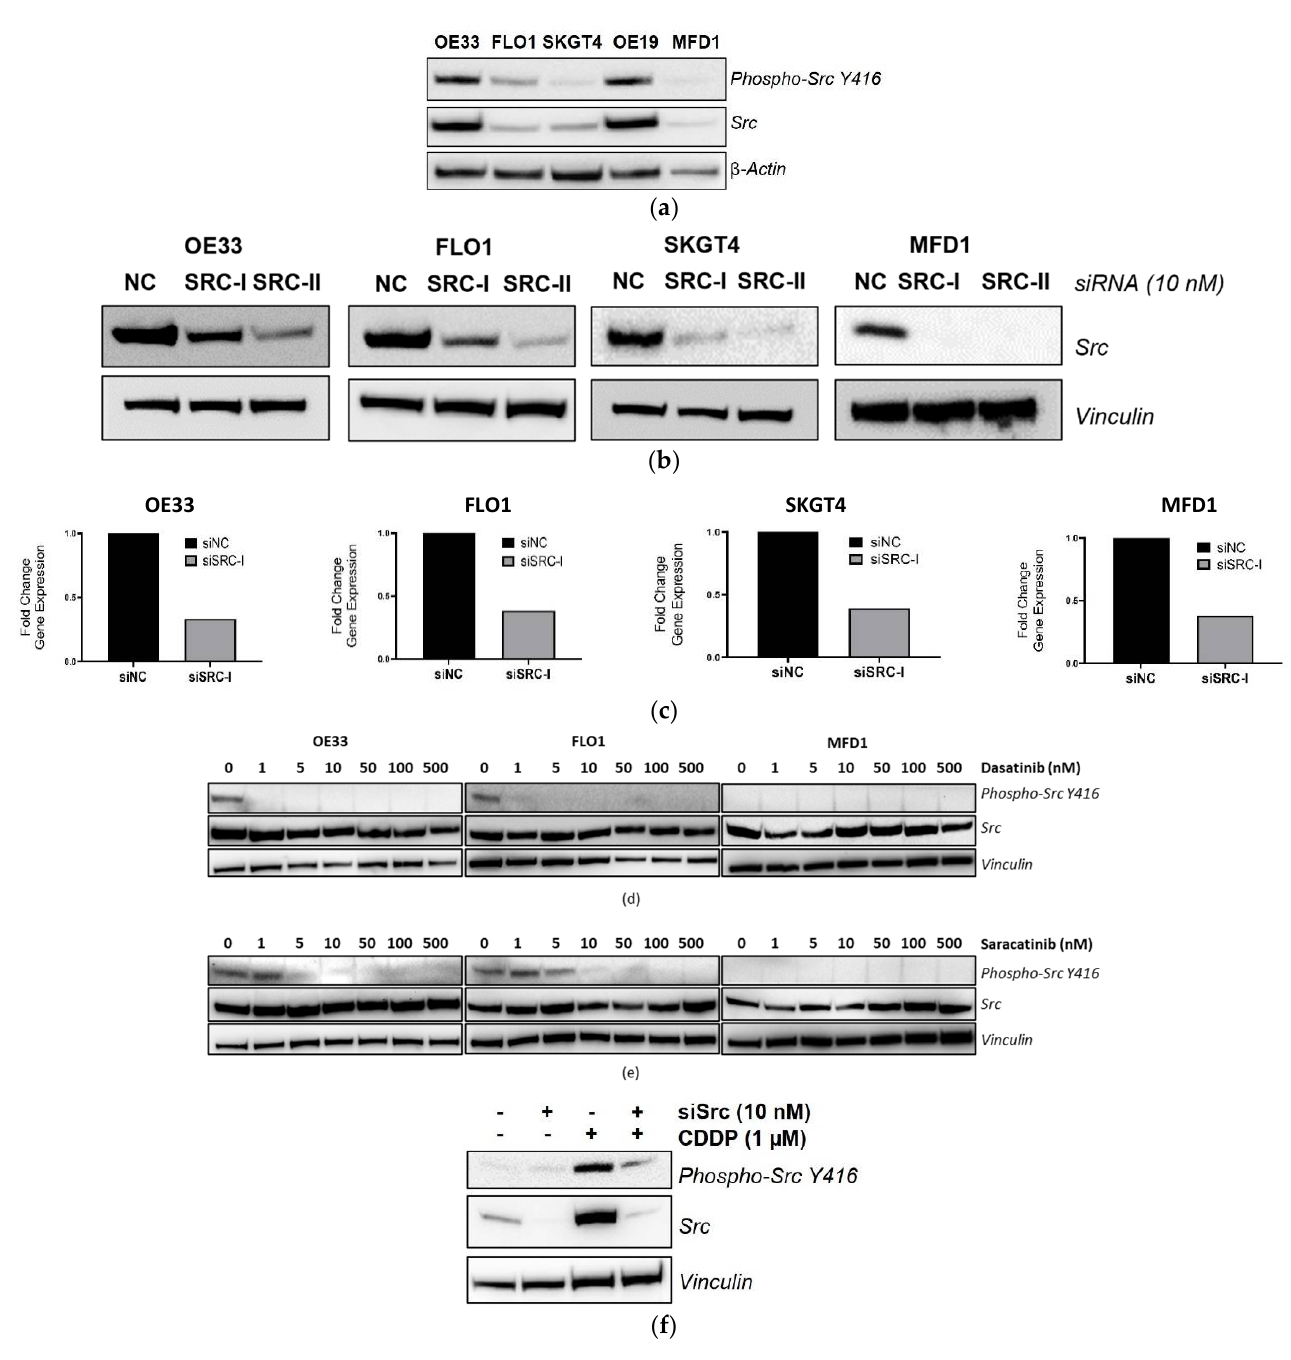
Figure 3. Src knockdown and inhibition in OAC cells. ( a ) Western blot analysis of basal phospho-Src Y416 and total Src protein in OAC cells with β -actin as a loading control. Src knockdown with 10 nM SRC-targeting siRNAs (SRC-I and SRC-II) for 72 h validated by ( b ) Western blot of protein levels with vinculin as a loading control and ( c ) Q-PCR of gene expression levels. NC, negative control siRNA. Western blot analysis of phospho-Src Y416 following 24 h treatment with ( d ) dasatinib or ( e ) saracatinib in OE33, FLO-1, and MFD1 cell lines with vinculin as a loading control. ( f ) Western blot analysis of phospho-Src Y416 and total Src in MFD-1 cells transfected with ( + ) 10 nM siSRC or ( − ) 10 nM siNC for 24 h prior to 48 h CDDP (1 µ M) treatment with vinculin as a loading control.